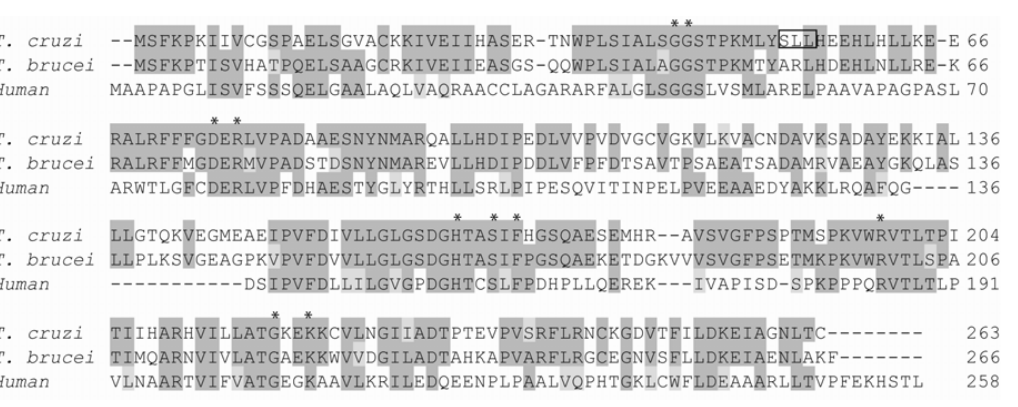
Fig. 3 – Alignment of the deduced amino acid sequences of different 6-phosphogluconolactonases. The accession numbers for the sequences aligned using the Clustal program are the following: T. cruzi EU077554, T. brucei AJ249255, Human AJ243972. Boxes shaded in dark grey show correspond to identical residues. The asterisks show the residues strictly conserved in the 6PGL family. Previous studies (Delarue et al. 2007) suggest that R77, F170, and R198 in the T. cruzi sequence could constitute the 6PGL signature. The grey box shows a putative internal PTS in the T. cruzi